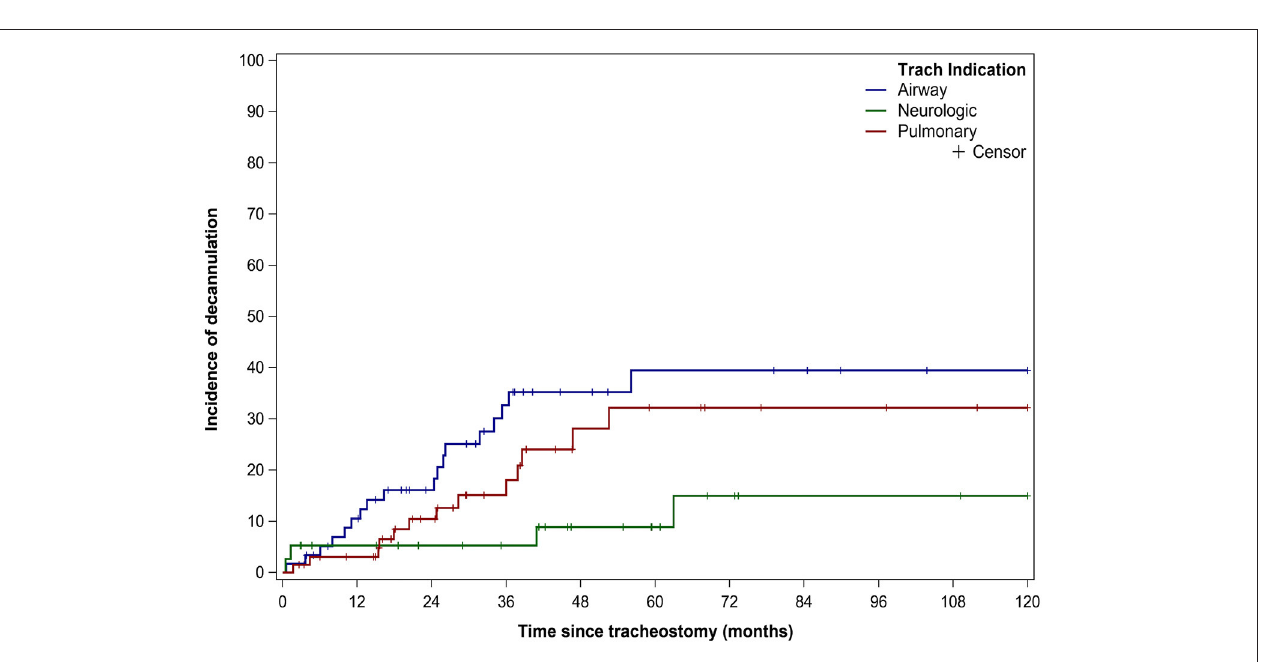
FIGURE 4 | Decannulation based on indication for tracheostomy. Decannulation rates based on tracheostomy indication: airway obstruction (18/59, 31%), pulmonary (13/66, 20%), and neurologic (5/39,13%). Trach,